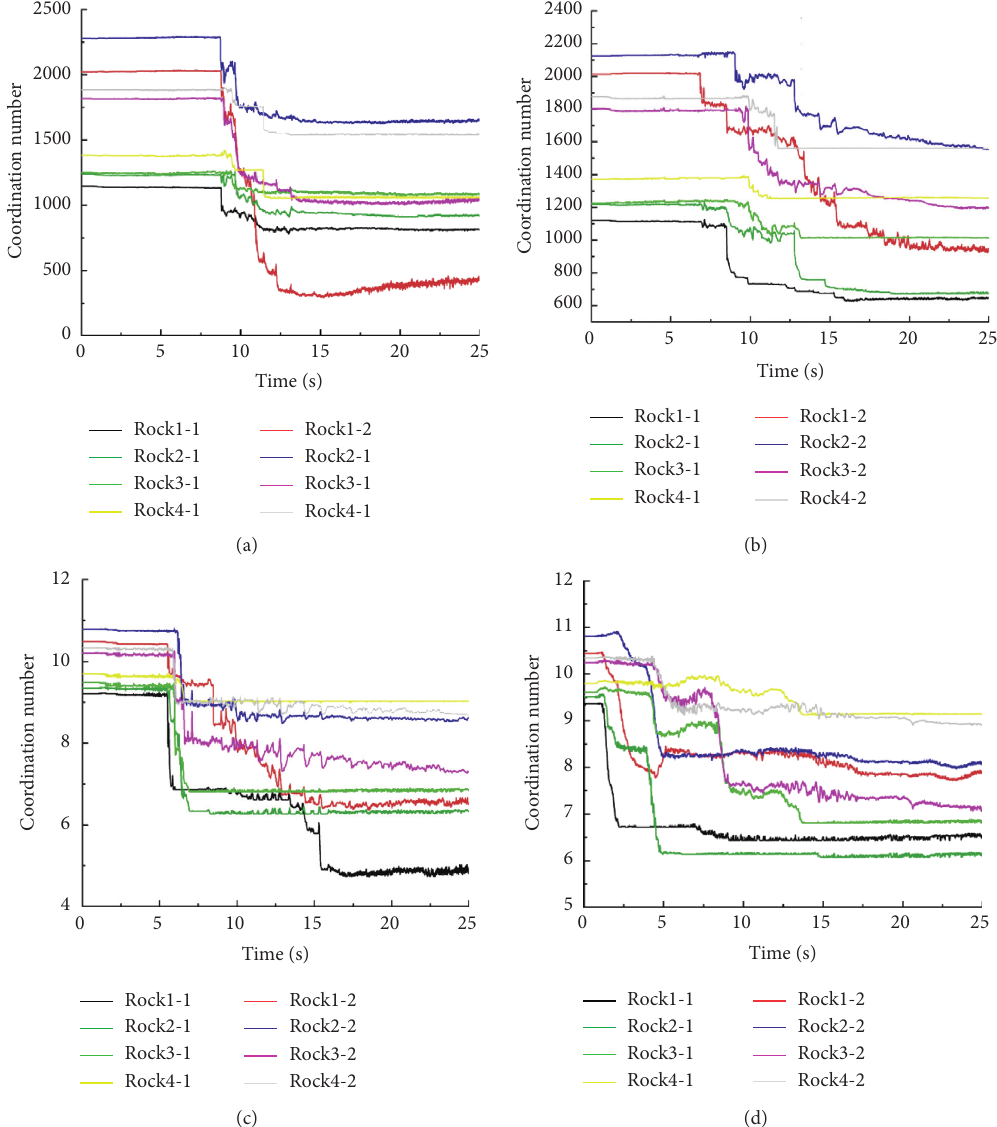
Figure 14: Time history curve of coordination number of each model. (a) Model 1. (b) Model 2. (c) Model 3. (d) Model